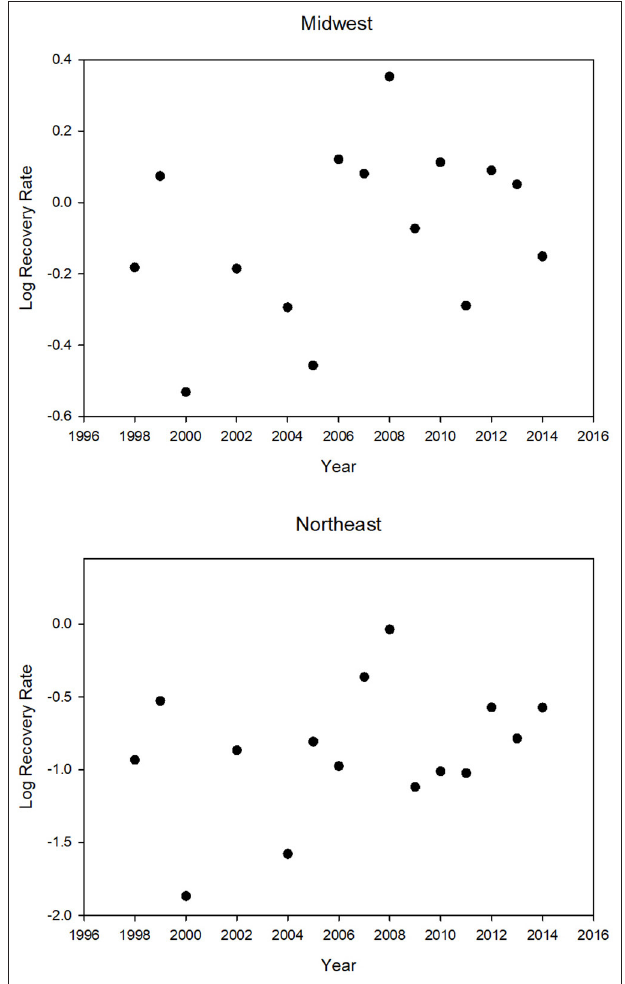
FIGURE 3 | Tag recovery rate (percent) for the Midwest and the Northeast for different years ( N = 15). The years 2001, 2003, and 2015 were excluded because a major winter mortality event in those years greatly increased the recovery rate. There is no significant trend in recovery rate. Log MW rec. rate = − 31.84 + 0.016 year ( R 2 = 0.11, p = 0.22), Log NE rec. rate = − 56.33 + 0.028 year ( R 2 = 0.10, p = 0.25). Note that the graphs have different scales for recovery rate; Northeast recovery rates are always